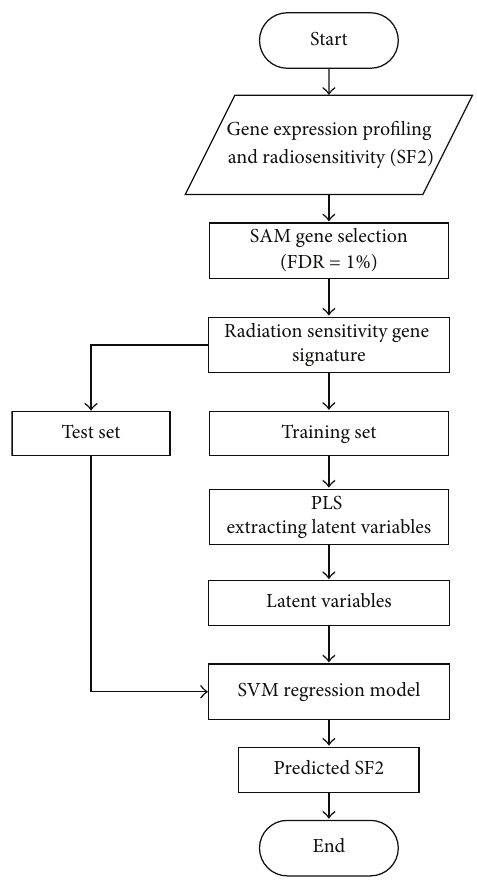
Figure 1: Flow chart of radiation sensitivity prediction model. Abbreviations: SF2—survival fraction at 2 Gy 𝛾 -ray radiation; SAM—significance analysis of microarrays; FDR—false